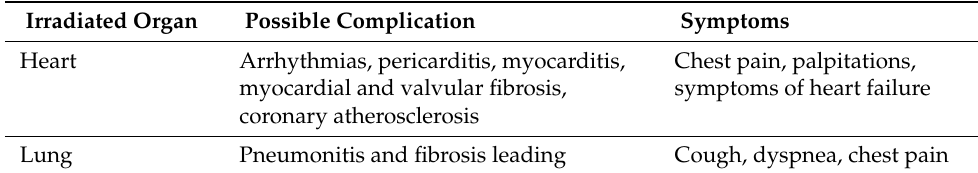
Table 4. Possible STAR-related organ